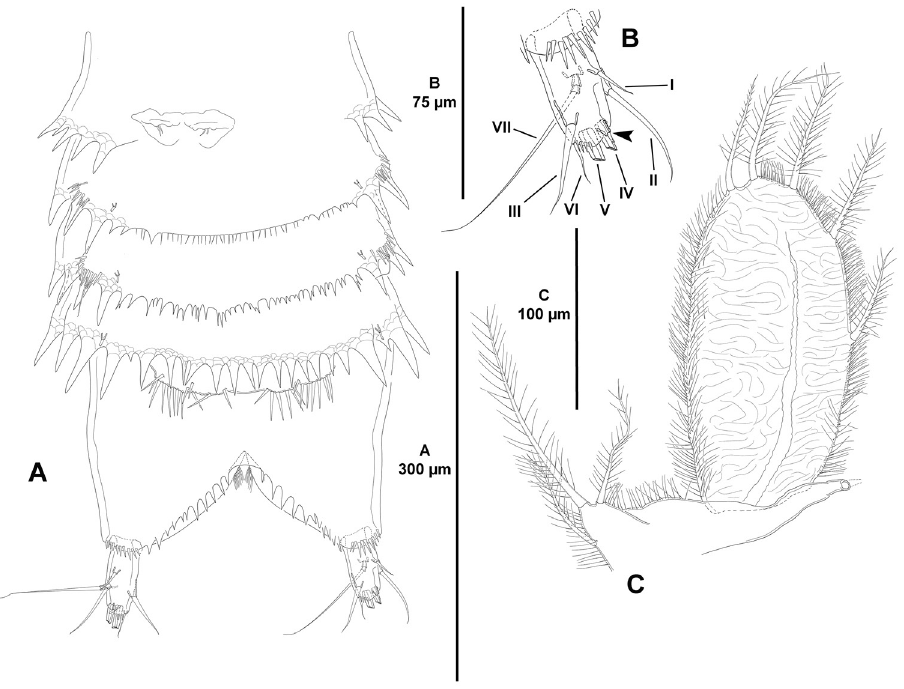
Figure 3. Eurycletodes paraephippiger sp. n., female holotype. A urosome, ventral (P5-bearing somite omitted) B caudal ramus, ventral (tube pore arrowed) C P5,